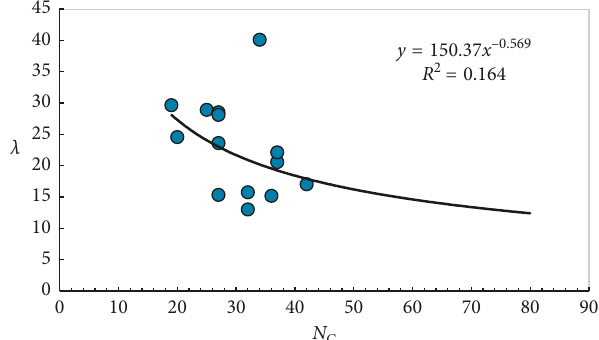
Figure 2: Relationship between λ and cutter number.